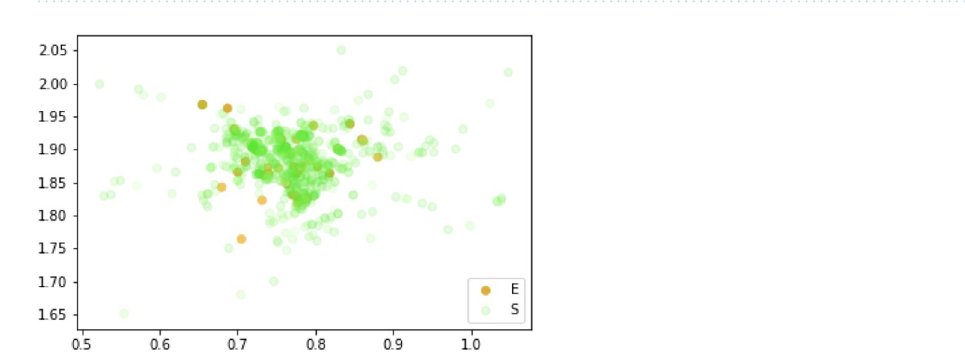
Table 2. The average AUC score. This is accurate enough to find the principle of our SEIR model, the ranking model of all data, on the condition that we eliminate the people with state I that do not have any surrounding features measured in up to three layers. The prediction divided people into two groups by probability of 0.5: either they will or will not be infected. The result of feature importance shows the contact time to the high-risk location which is more relevant for judging whether someone has been infected or not, and where X I and X E are the total numbers of state I and E in the first three surrounding layers, respectively.